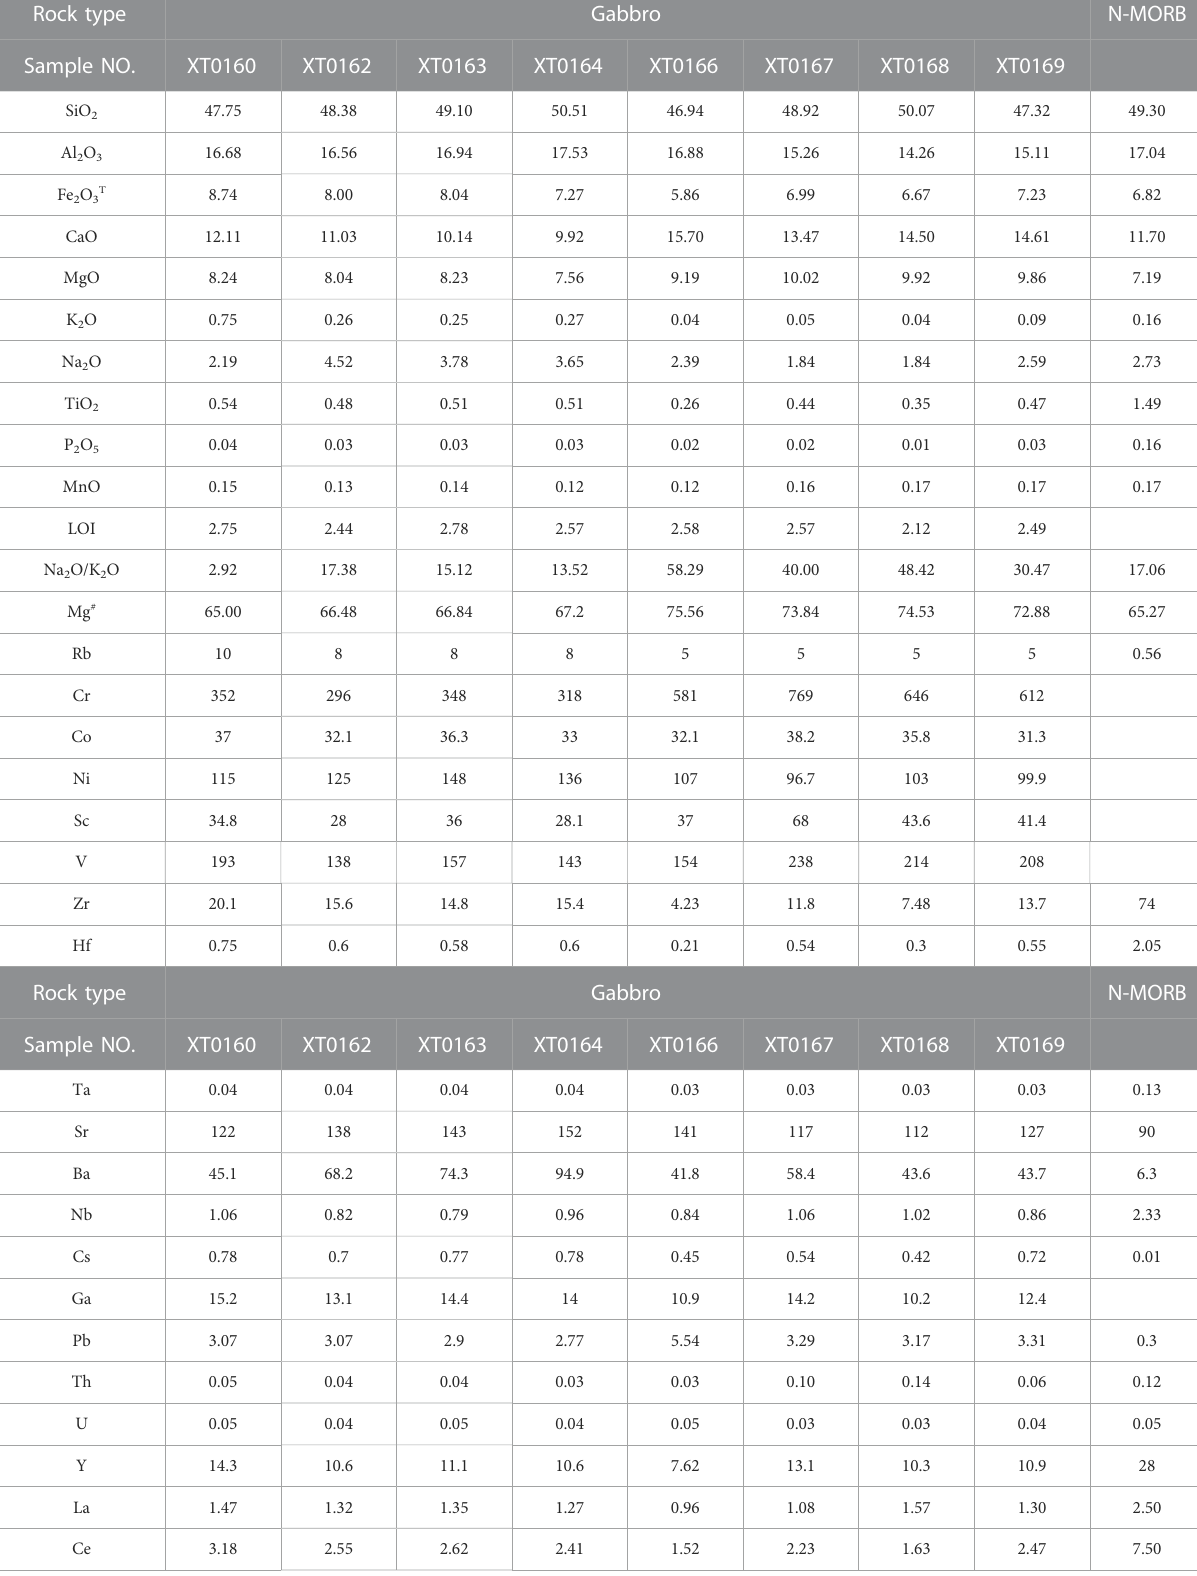
TABLE 2 Major (wt%), trace element (×l0 − 6 ) analyzing results of the gabbro in Diyanmiao ophiolite and N-MORB. Rock type Gabbro N-MORB Sample